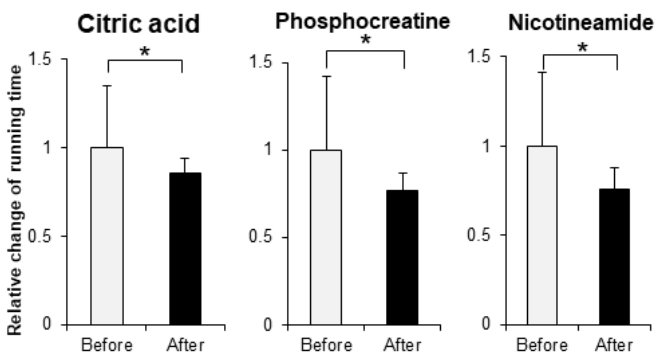
Figure 3. Antioxidants that enhance the running activity of muscle- Sod2 -/- mice. Positive effects of antioxidants on the treadmill task performance of muscle- Sod2 -/- mice (top) and structural formulas of each compound (bottom). * p < 0.05. Data are shown as the mean ± SD.